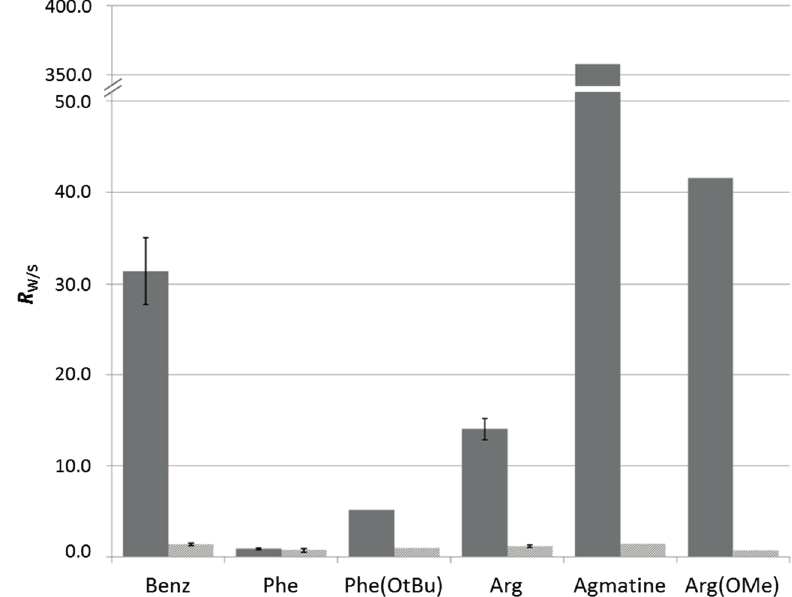
Figure 3. Selective retention of aminated products ( R W/S ) with different amines in the presence of either cellulose (light grey) or dT n on cellulose (dark grey). Error bars represent the standard